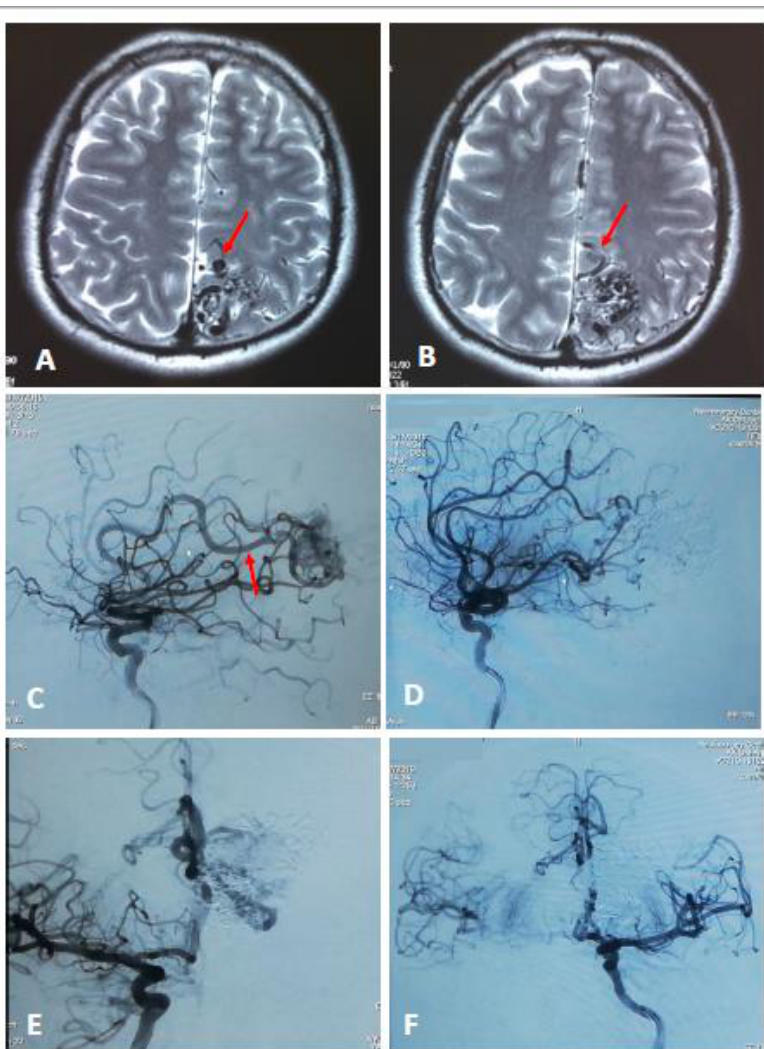
Figure 2. Axial MRI of grade 3 brain AVM demonstrates varix ( A, red arrow) and dilated afferent vessel ( B, red arrow). Lateral view angiogram demonstrates dilated afferent artery before embolization ( C, red arrow) and after ( D ). Anterior-posterior view angiogram before total embolization ( E ) and after ( F ).